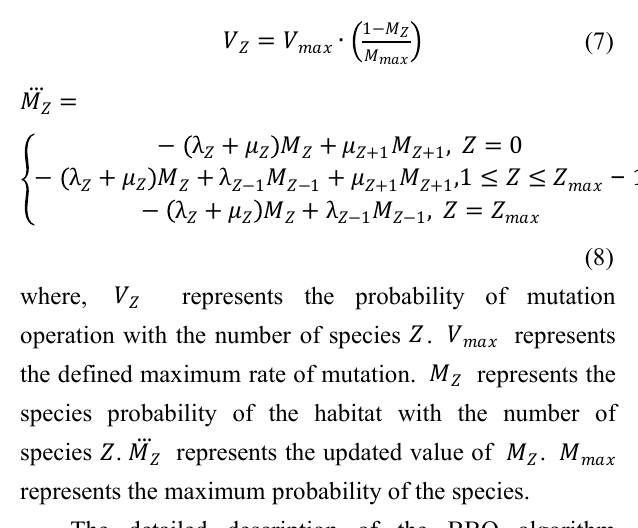
The detailed description of the BBO algorithm